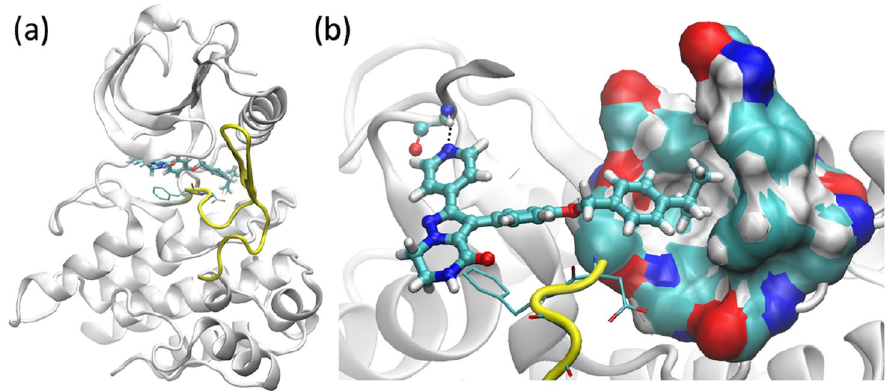
Figure 2. Structures of ROS1 complexed with compound L2: ( a ) overall structure and ( b ) the binding site, showing the hydrophobic binding pocket and a hydrogen bond (dashed line) of the compound with one hinge residue. The compound is shown in ball-and-stick representation. The activation loop (yellow), beginning with a conserved DFG motif (thin sticks), adopts an inactive DFG-out